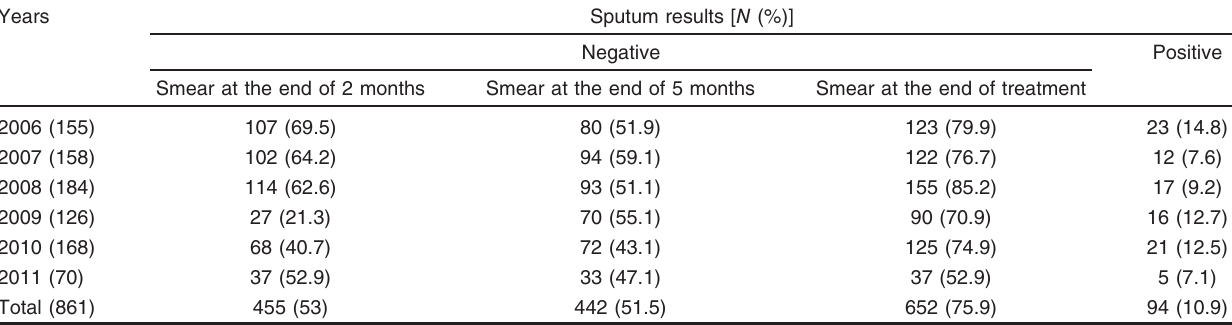
Table 6 Conversion rate for all tuberculous cases and statistical analysis between negative and positive cases during the period of the study (2006 –